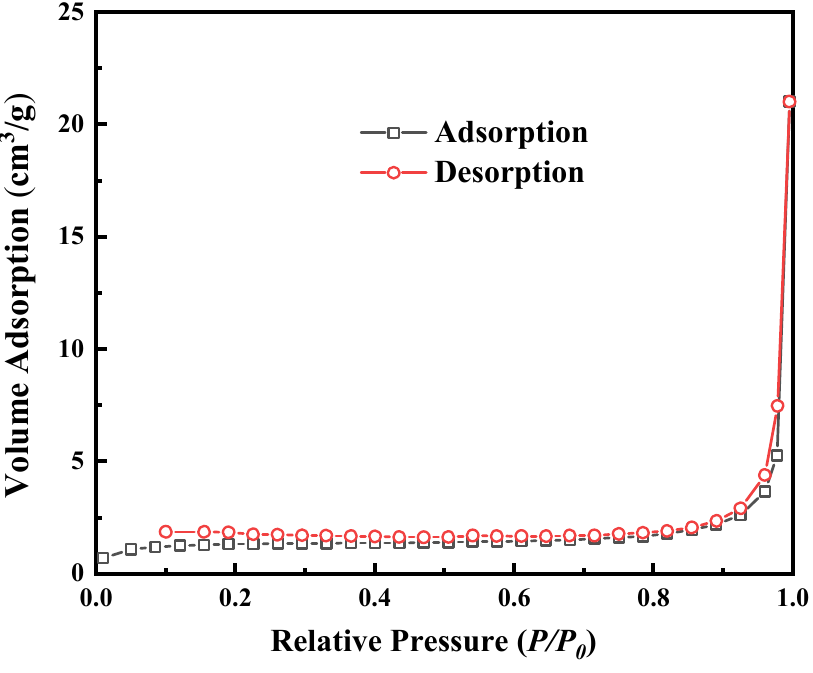
Figure 4. Nitrogen adsorption–desorption isotherm of MMIPs.